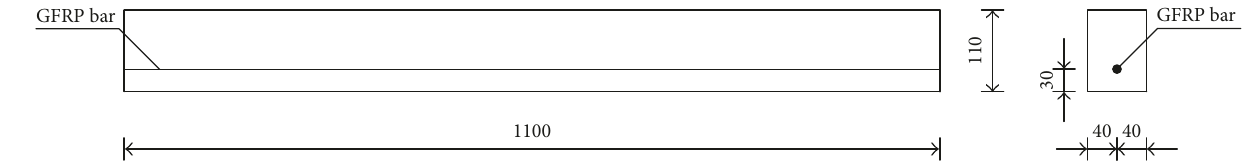
Figure 1: Design figure of GFRP reinforced fiber reinforced concrete beam (unit: mm).